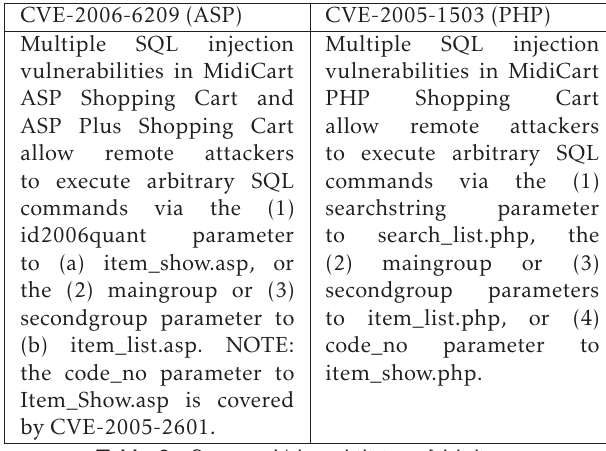
Table 3. Common Vulnerabilities of